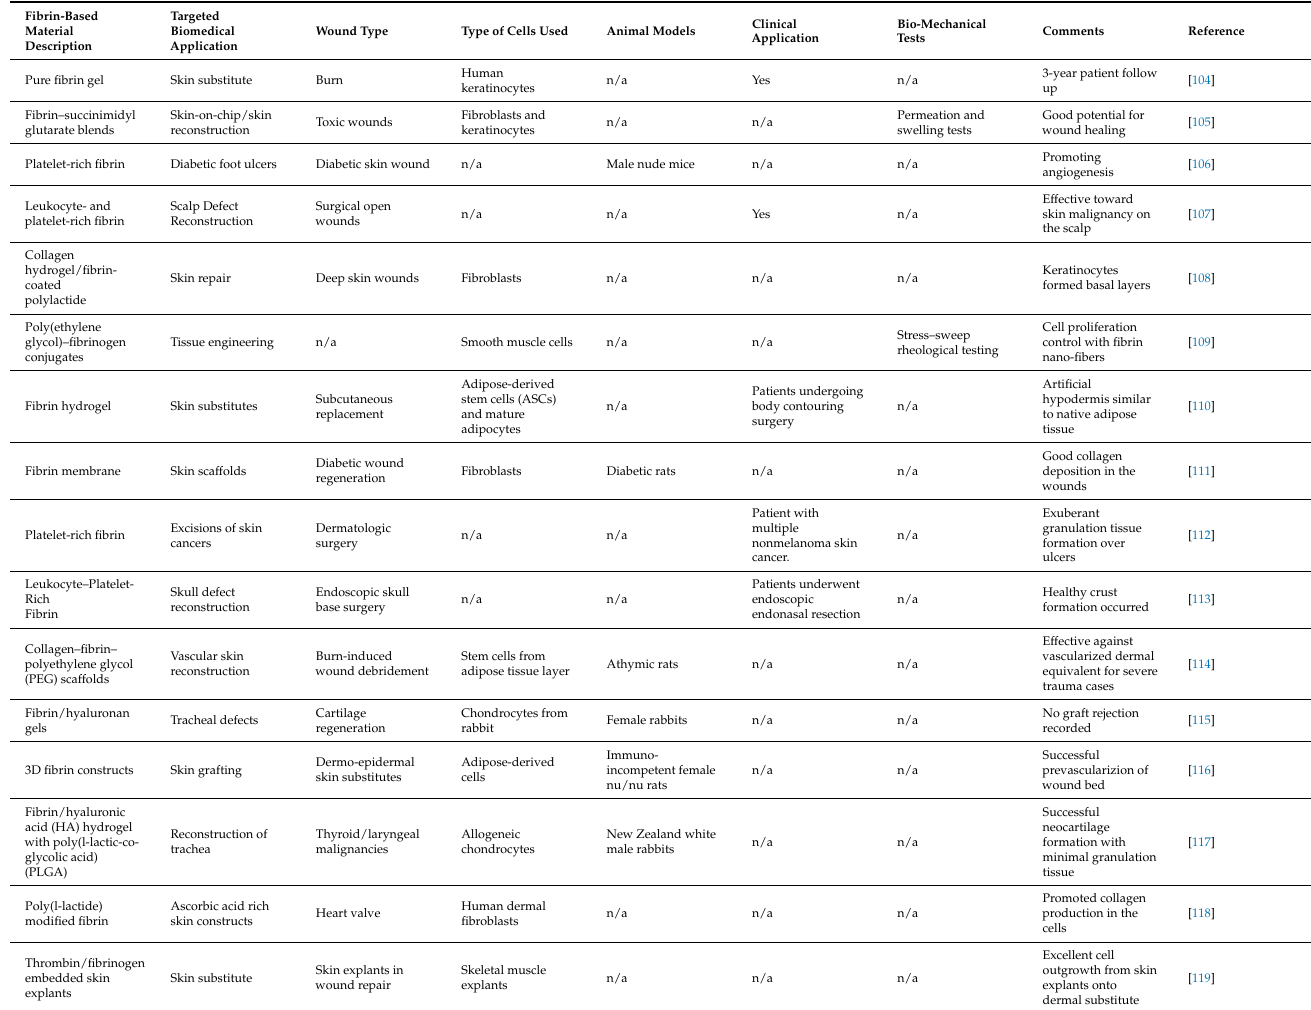
Table 1. Summary of notable studies on skin reconstruction applications enabled by fibrin-based